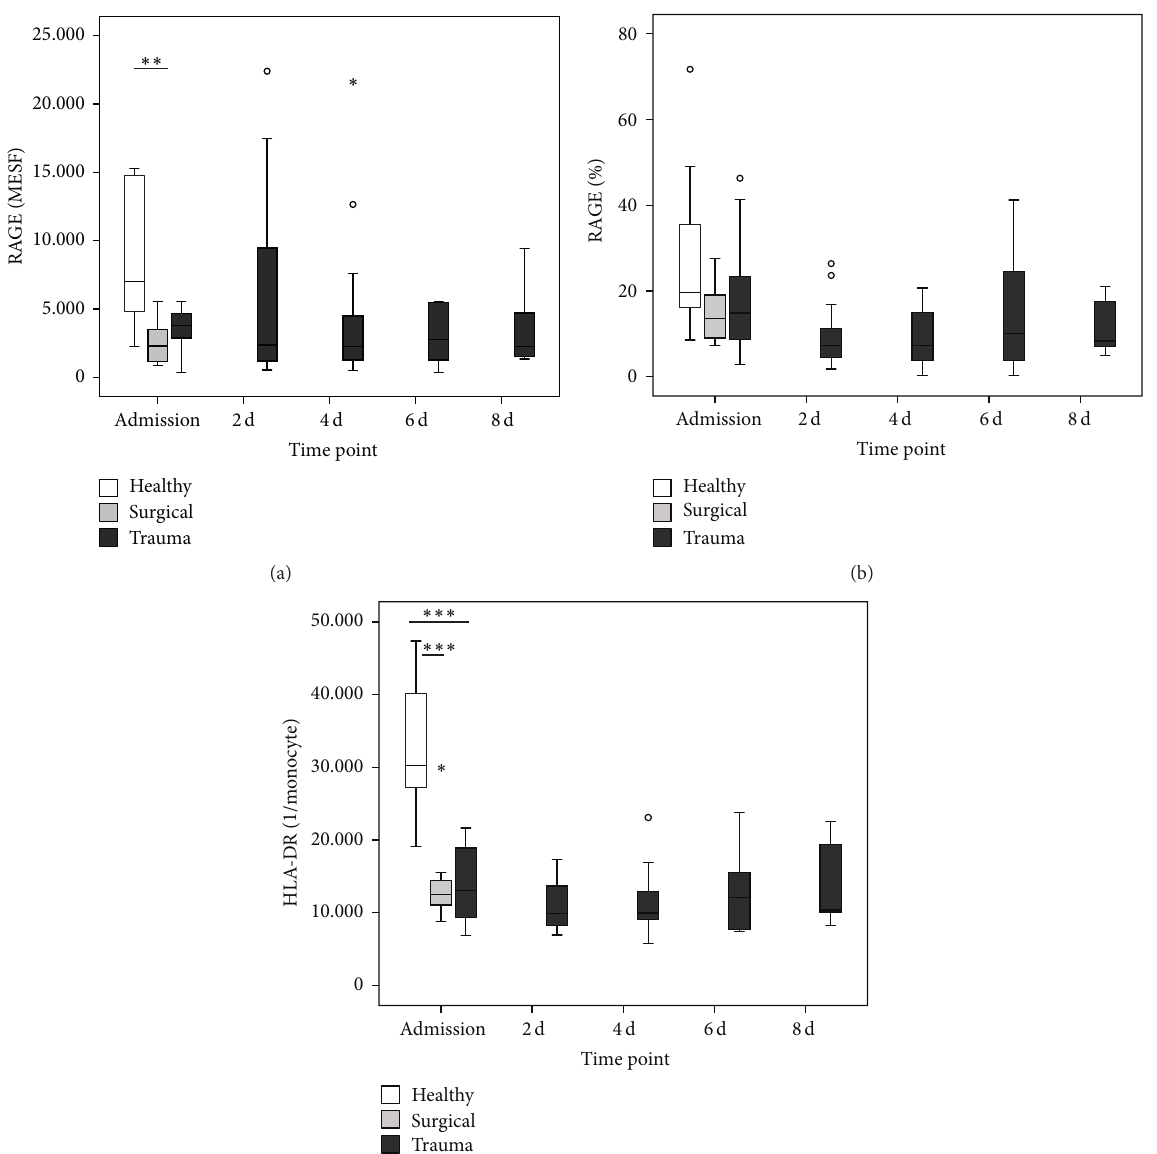
Figure 2: Cell surface expression of RAGE and HLA-DR. Results for RAGE are given as Molecules of Soluble Fluorochrome (MESF) (a) and percentage of RAGE + monocytes compared to isotype (b), HLA-DR as mean amount of molecules per monocyte (c) at admission ( 𝑛 = 16 /10/10 for trauma/surgical/healthy) and 2d ( 𝑛 = 16 ), 4 d ( 𝑛 = 14 for RAGE), 6 d ( 𝑛 = 10 ), and 8 d after trauma ( 𝑛 = 8 ). ∗ 𝑃 < 0.05 , ∗∗ 𝑃 < 0.01 , and ∗∗∗ 𝑃 < 0.001 compared to trauma at admission (Mann-Whitney 𝑈